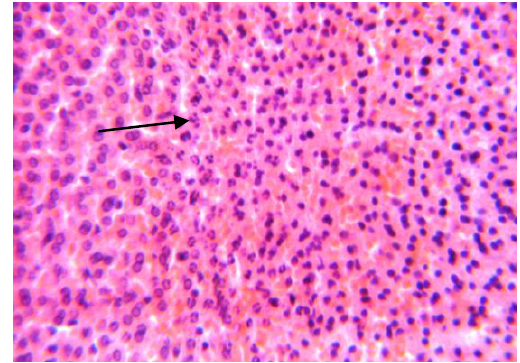
Fig (16): liver at day 3 pi. showed sever infiltration of polymorph-nuclear cells ( ) between swollen hepatocytes ( H&EX40).